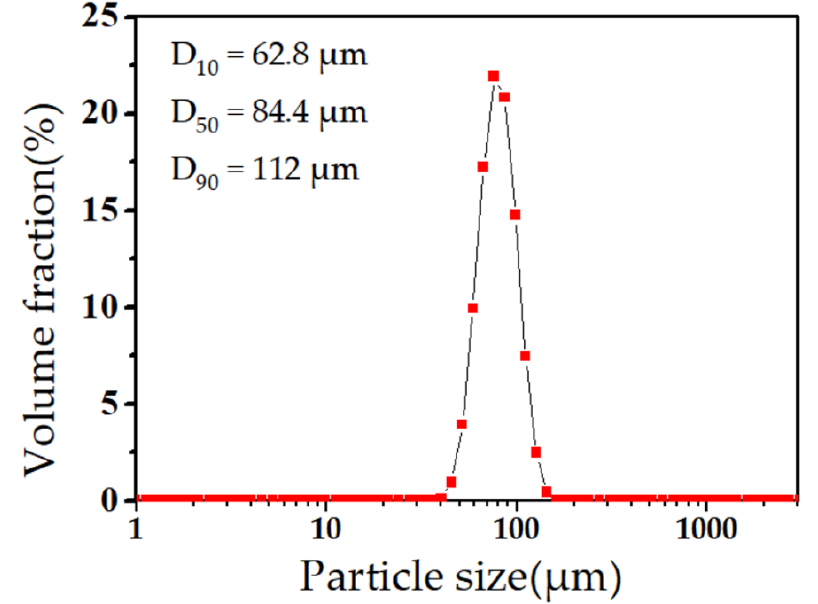
Figure 2. The particle size distribution of Ni-coated Al powders. Table 1. The parameter details of cold spraying Ni-coated Al particle and coatings.